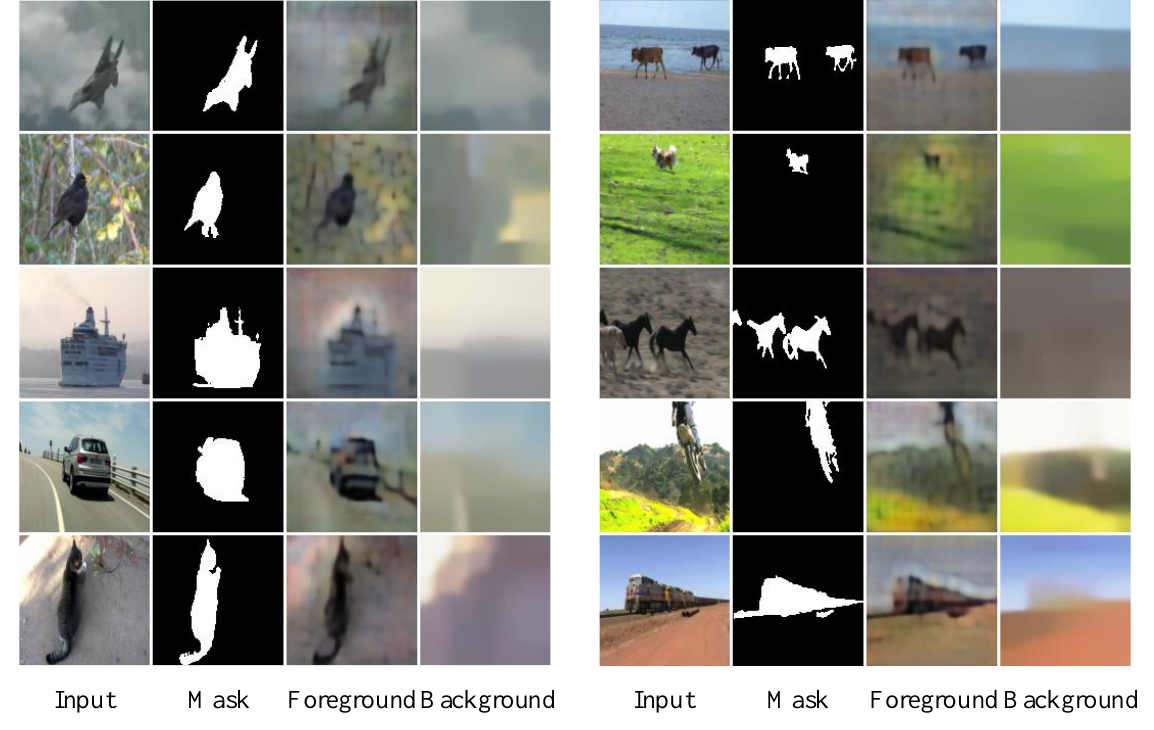
Mask Foreground Background Input Mask Foreground Background Figure 8. The visualization results on the validation set of the YouTube Objects dataset. For each class, we show the segmentation mask, foreground and background extracted by OLSeg.